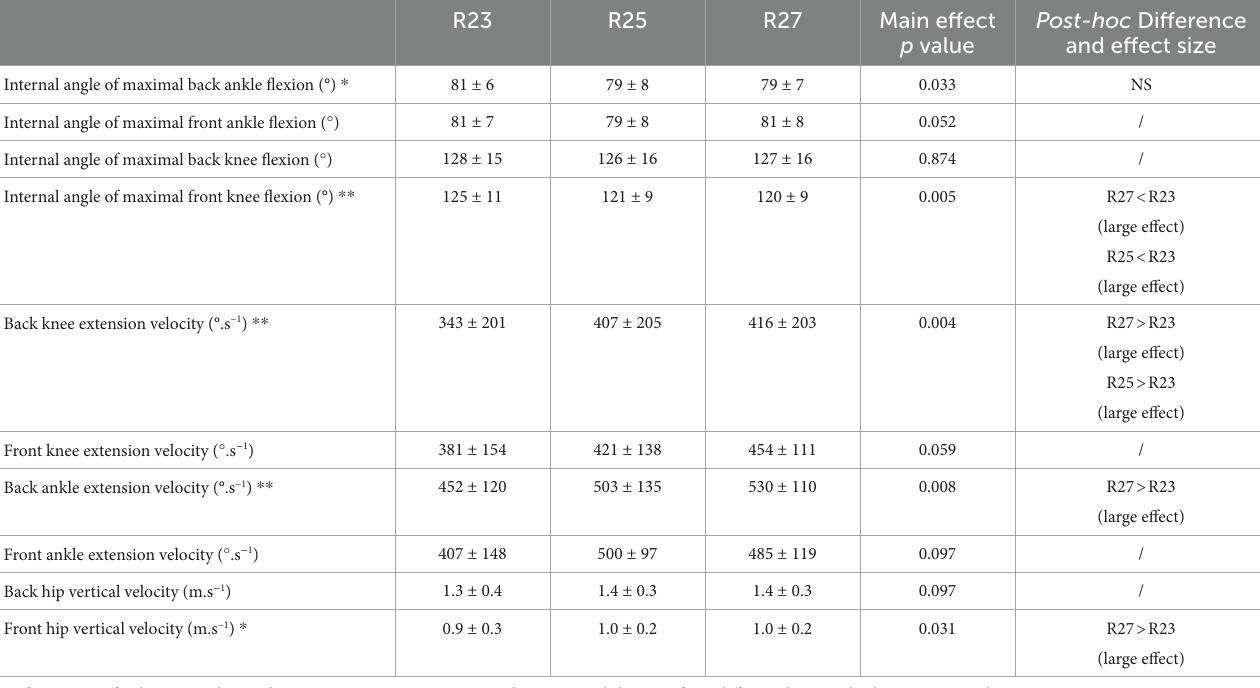
TABLE 5 Maximal lower body kinematics for the different racket conditions (mean ±